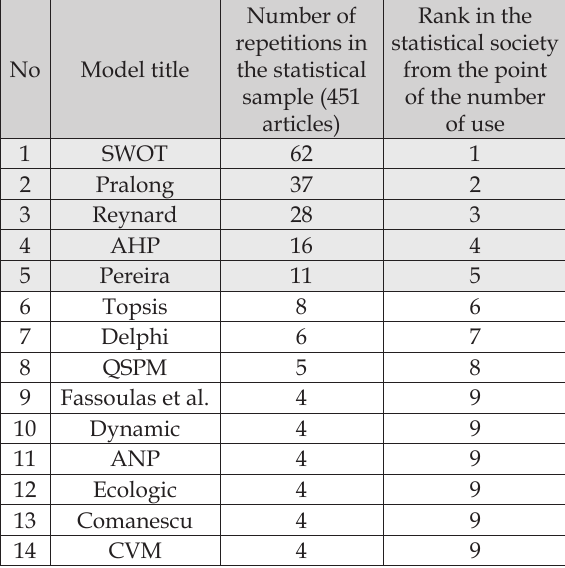
Table 2. The most repetitive models within the statis- tical